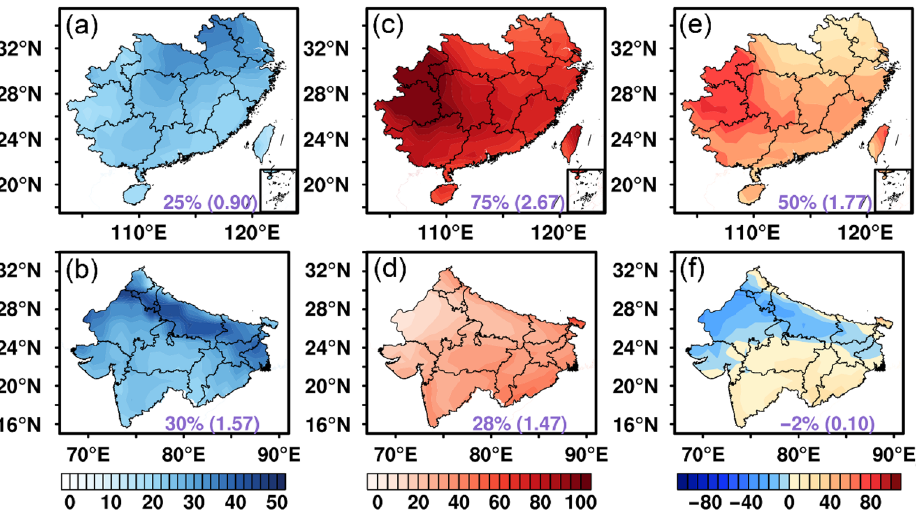
Figure 3. The effects of aerosols and clouds on POAI over the SC (top panels) and the NI (bottom panels): ( a , b ) PAE; ( c , d ) PCE; ( e , f ) PCE minus PAE (Unit: %). The numbers outside the parentheses within each panel denote the regional averaged PAE and PCE, while the numbers inside the parentheses represent the regional averaged AE and CE (Unit: kWh/m 2 /d). The map was generated by ESRI ArcGIS 10.5 software available at the ESRI website (https:// www. esri. com/ en- us/ arcgis/ produ cts/ arcgis- platf orm/ overv iew). The administrative boundary shapefile for southern China is available at the RESDC website (https:// www. resdc. cn/) and the administrative boundary shapefile for northern India is available at the GADM website (https:// gadm. org/ downl oad_ count ry.